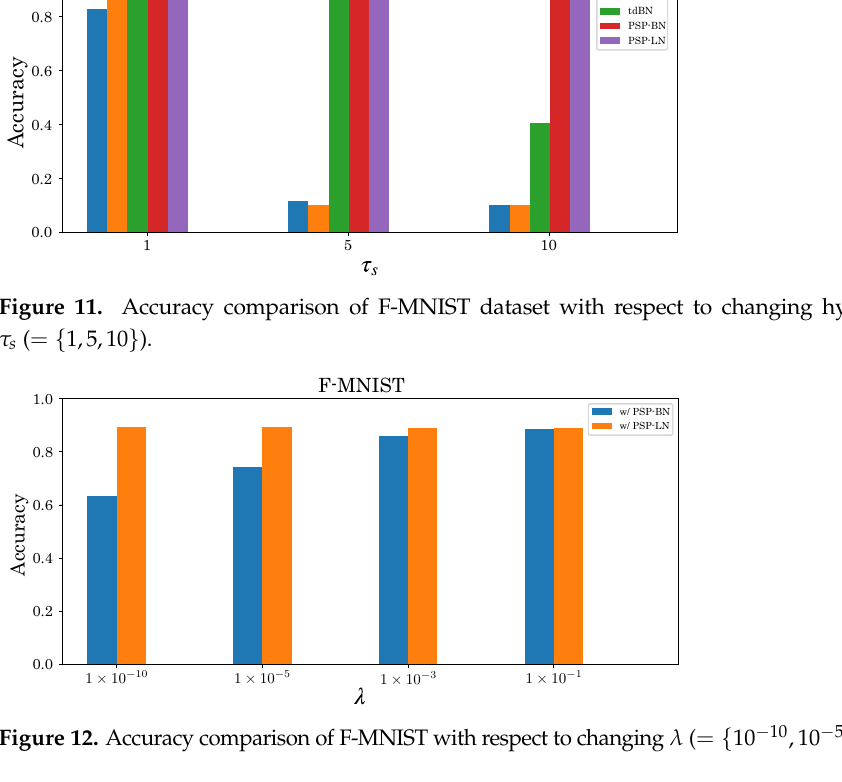
10 − 10 ,10 − 5 ,10 − 3 ,10 − 1 { }